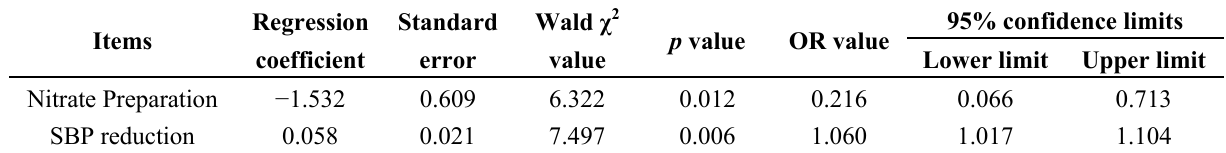
Table 5. Logisitc regression analysis of risk factors of LVMI change in CAPD